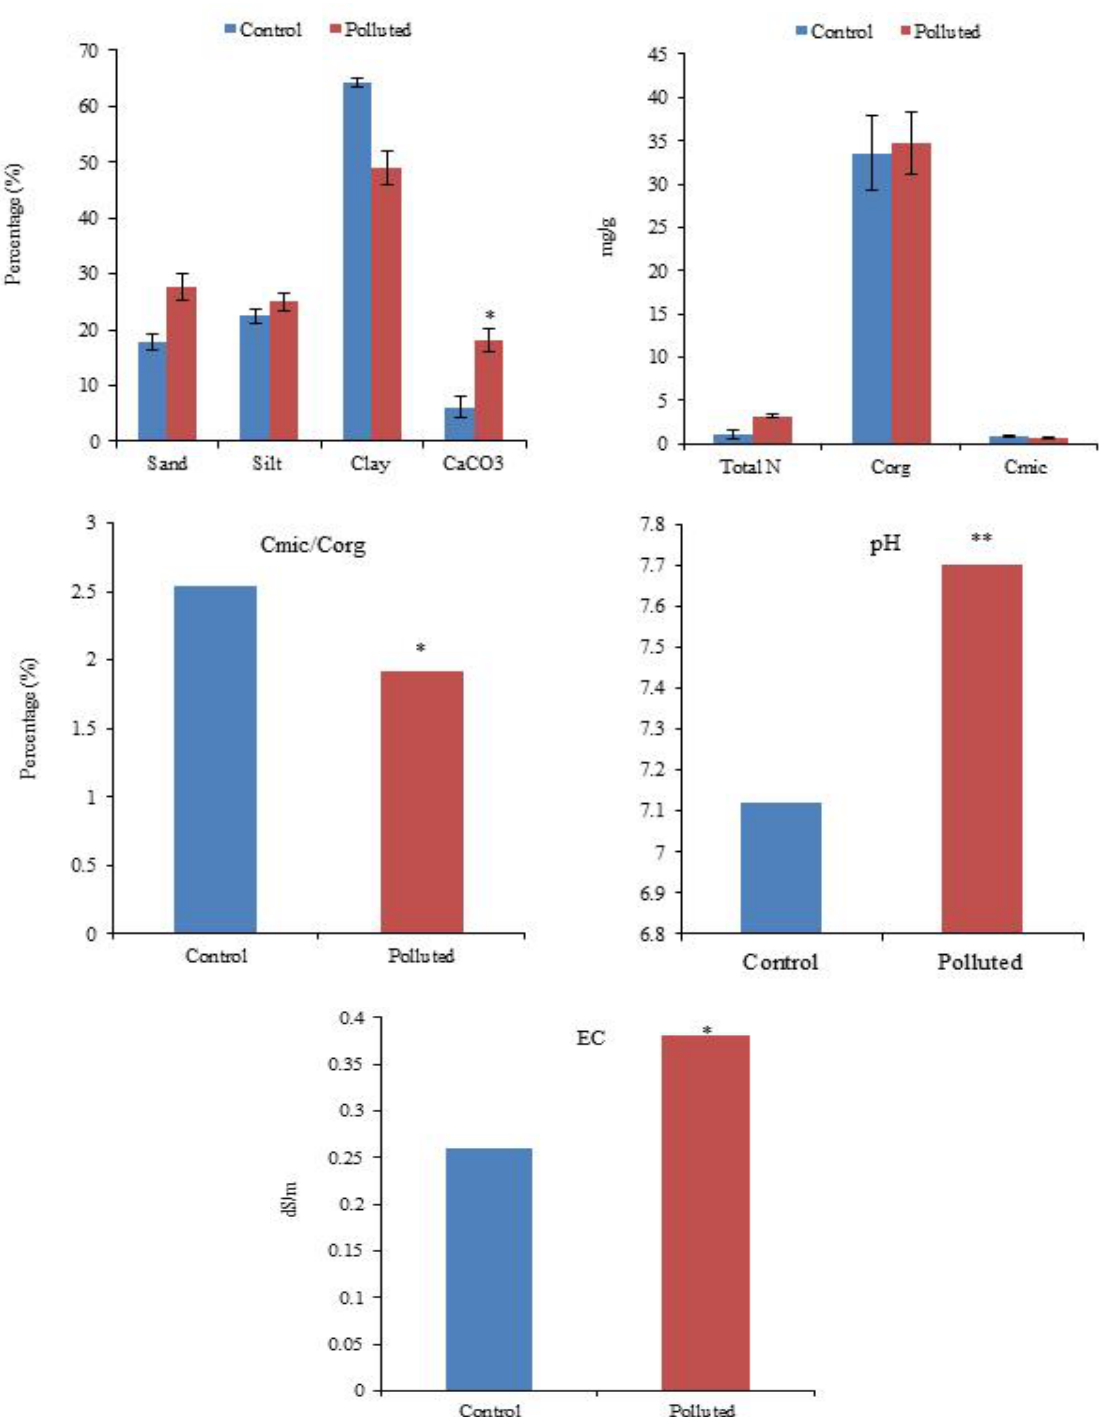
Fig. 1: Physicochemical and biological properties of soil. Values are means of three replicates. Asterisks indicate significant differences between control and polluted soil; *, pd”0.05; **,